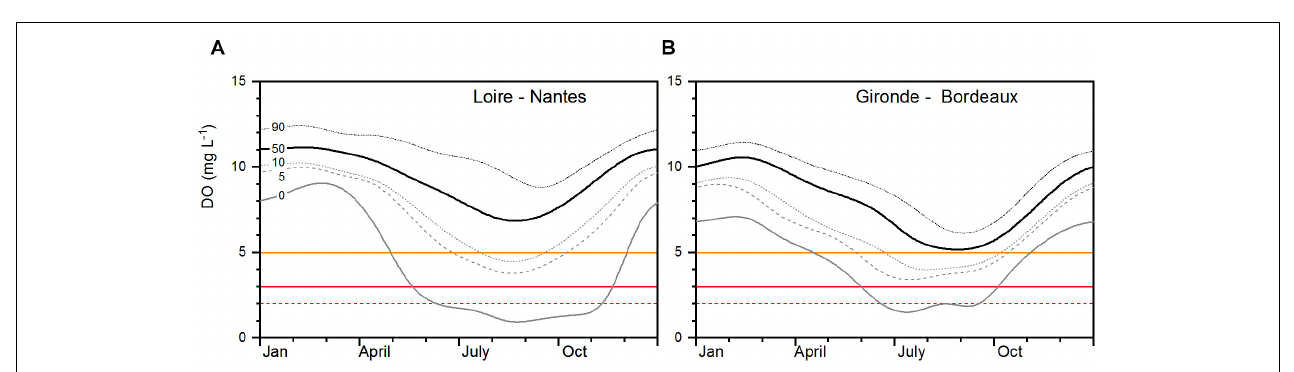
FIGURE 2 | Comparison of high-frequency DO records in the urban section of the Loire ( A ; 452,433 measurements) and Gironde ( B ; 506,167 measurements) estuaries. Gray areas underline DO concentrations corresponding to hypoxia stricto sensus .